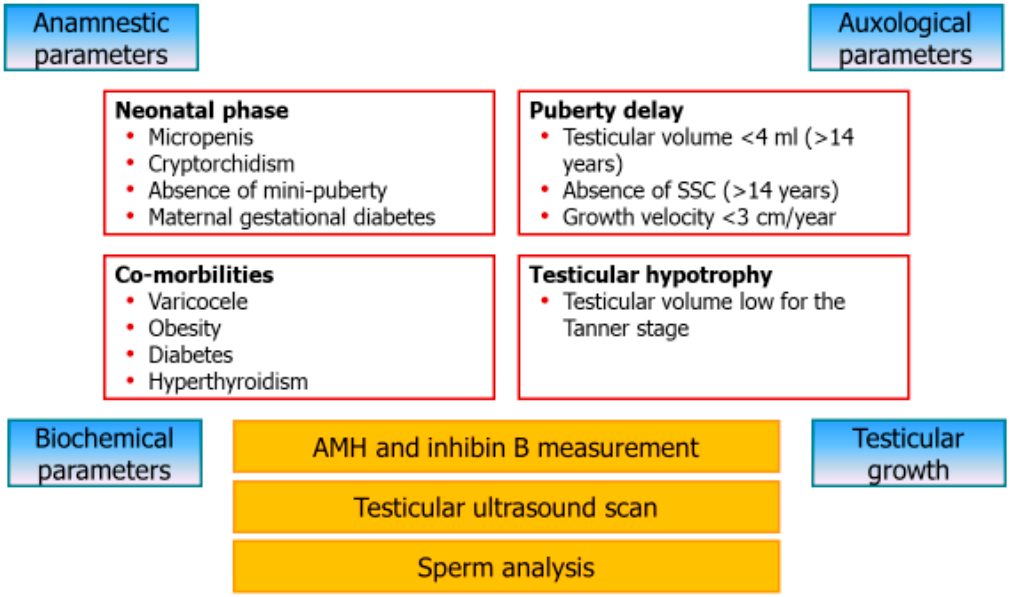
Figure 1. Diagnostic flow-chart for the early detection of Sertoli cell dysfunction. Children or transitional age adolescents showing anamnestic or physical signs at risk for Sertoli cell (SC) dysfunction should undergo to the assessment of biochemical parameters, testicular ultrasound and, whenever possible, sperm analysis.